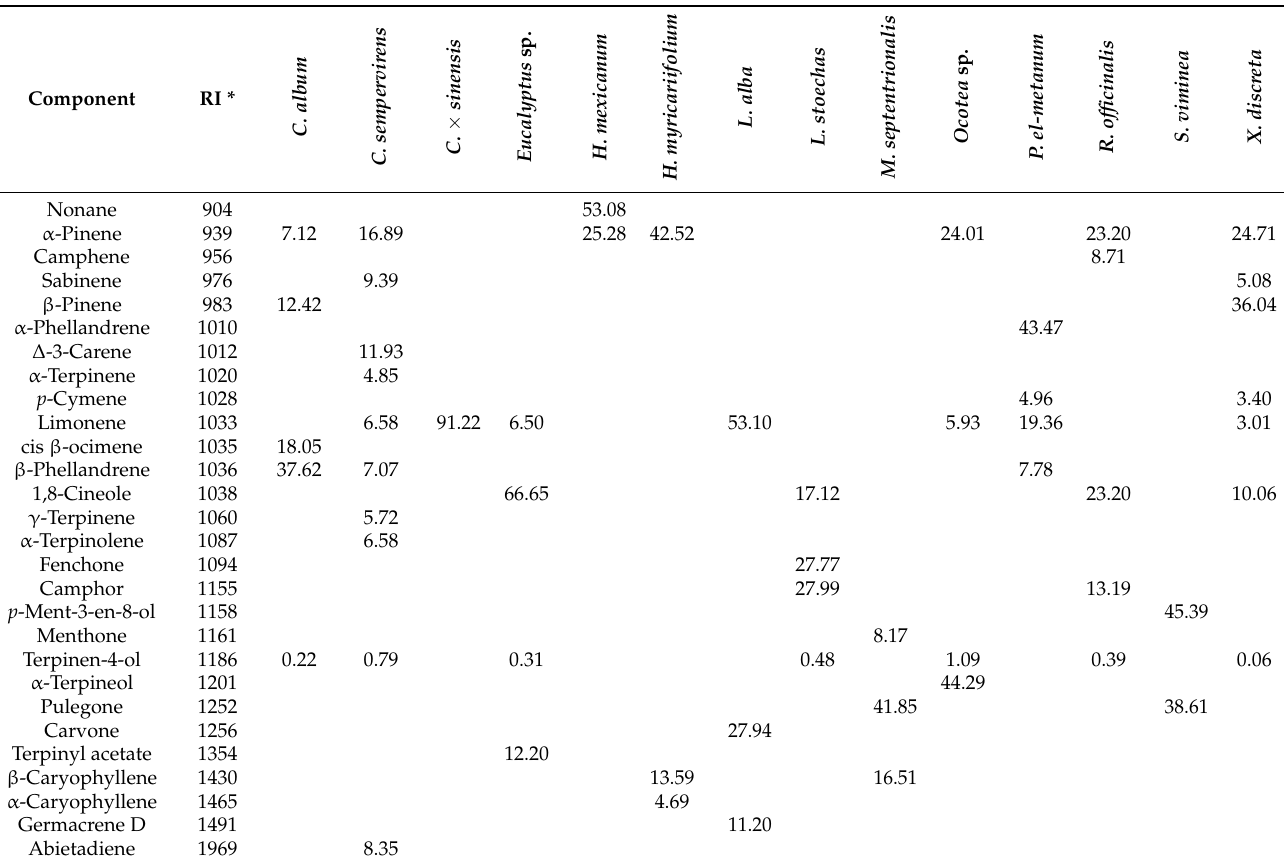
Table 4. Percentages of the main components of the 14 EOs with potential fumigant activity on S. zeamais .